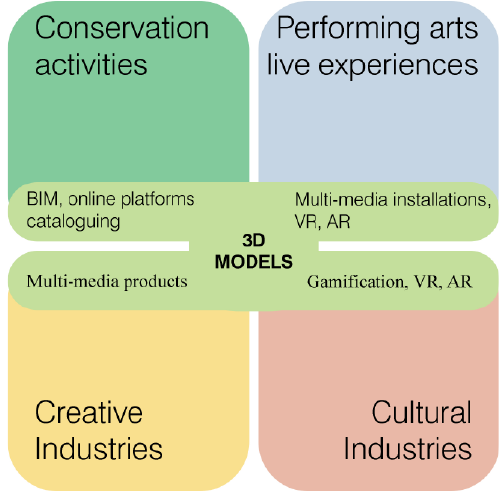
Figure 5 . The core of the CCPS, combined with the most common uses of 3D models.